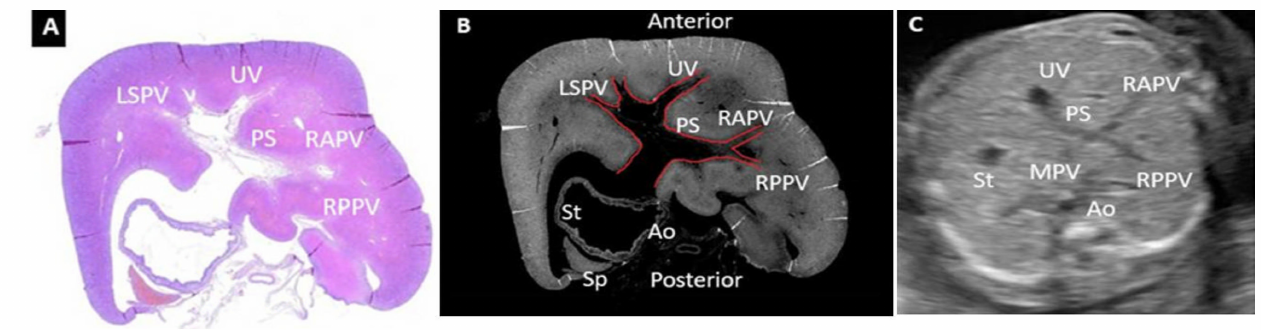
Figure 7. Histopathological and ultrasound aspect of normal FT liver. ( A ): Normal histological appearance of the FT liver, demonstrating the UV, LSPV, PS, RAPV, RPPV. Classic hematoxylin-eosin staining, × 100; ( B ): image processed in negative format which highlights more strongly the elements described in image ( A ); ( C ): transverse view of the fetal abdomen on grey scale showing the UV, MPV, PS, RAPV, RPPV, St, Ao. UV: umbilical vein, LSPV: left superior portal vein, PS: portal sinus, RAPV: right anterior portal vein, RPPV: right posterior portal vein, St: stomach, Ao: aorta, Sp: